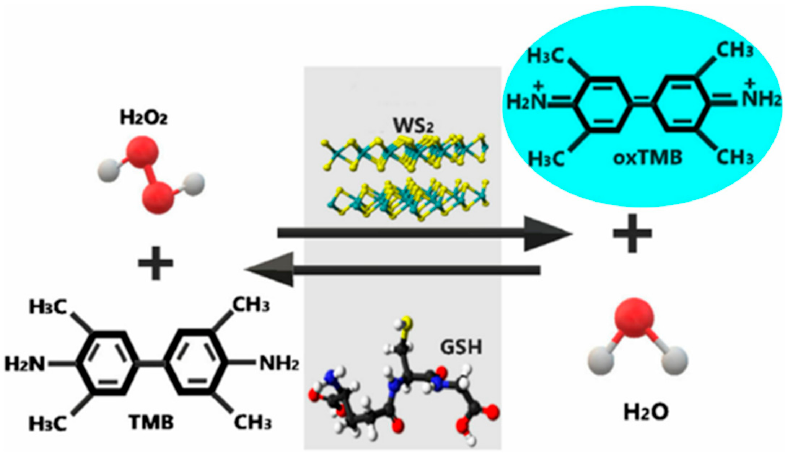
Figure 8. Colorimetric determination of GSH by tungsten disulfide. Reprinted with permission from Ref. [78], Copyright 2019, Royal Society of Chemistry.